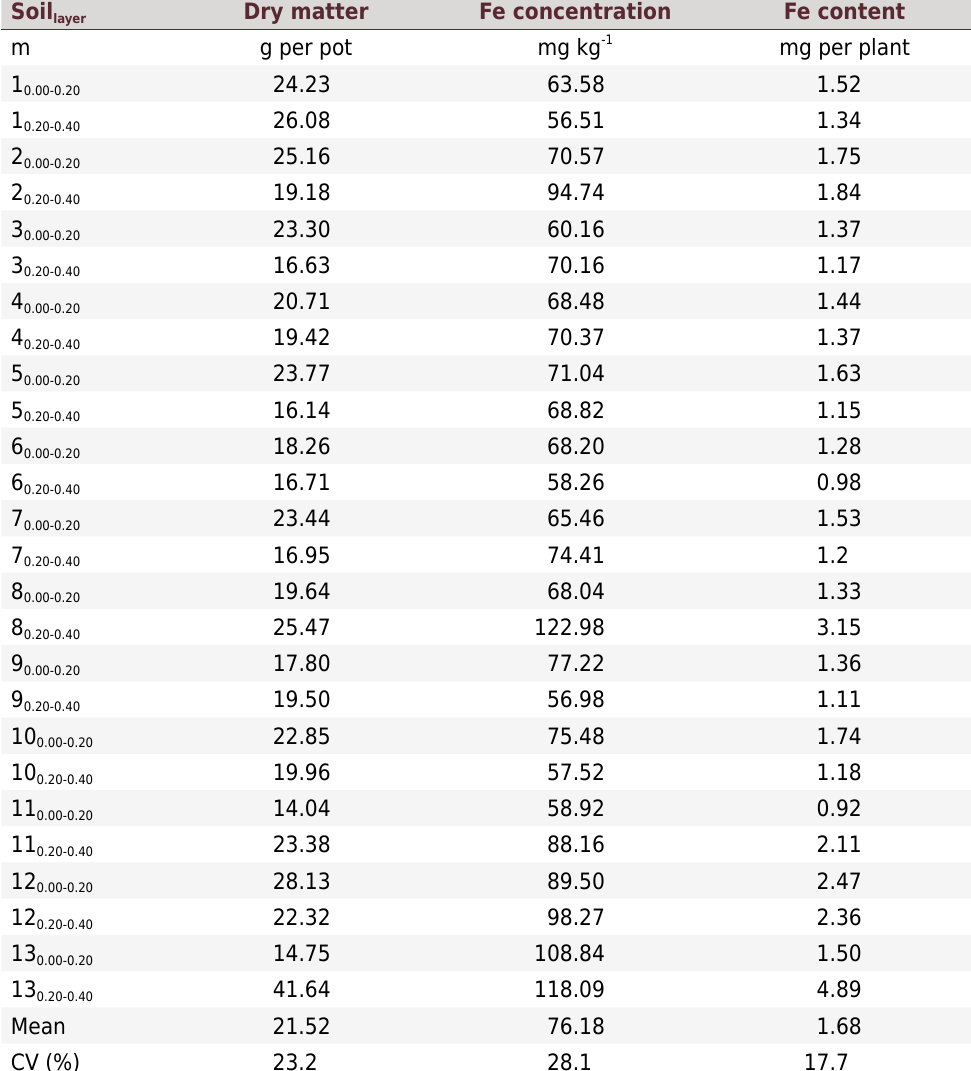
Table 6. Dry matter, concentration, and content of Fe in plants cultivated in samples of 13 soils collected at two depths Soil layer Dry matter Fe concentration Fe content m g per pot mg kg -1 mg per